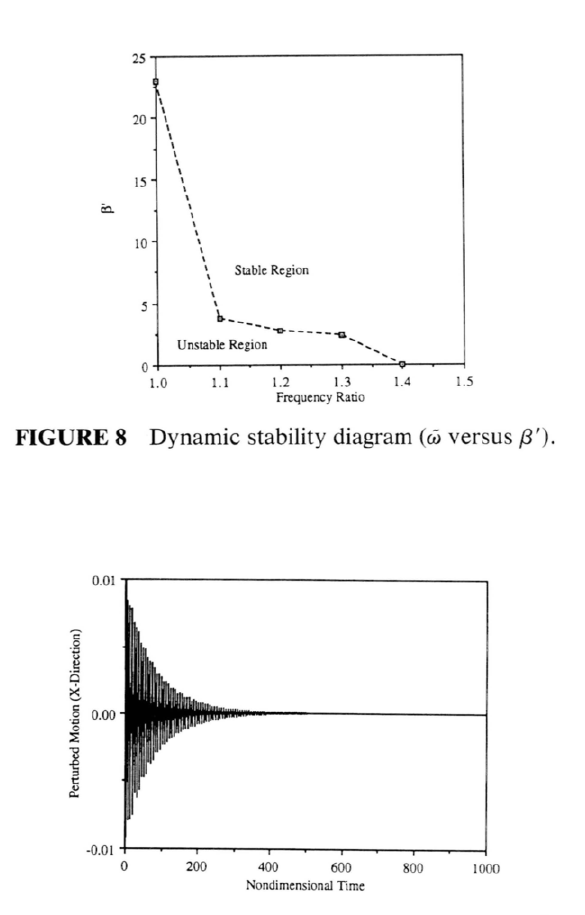
FIGURE 9 X-direction perturbation versus nondi mensional time (w = 1.5). Initial conditions: XI (0) = .91(0) = 0.Q1 , i ,(O) = YI(P) = 0, ~sl = 3. 13, ¢ s2 = 3.15, ¢I(O) = ¢ 2(0) = 0.01 , ¢I(O) = ¢ 2(0) = 0, m = 0.005, R = 0.001, and {3' = .01.